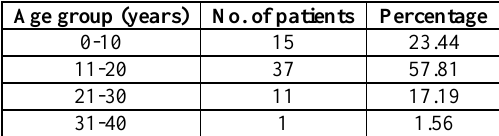
Table I. Age distribution of patients